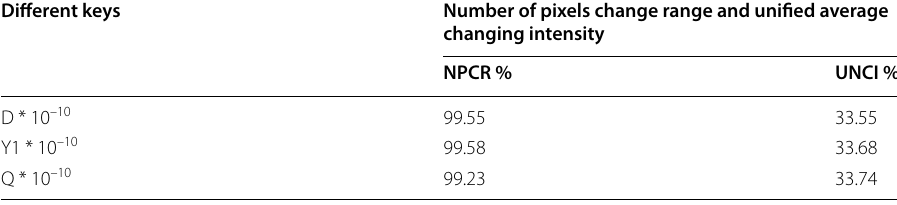
Table 4 Number of pixels change range and unified average changing intensity for i‑frames with different keys